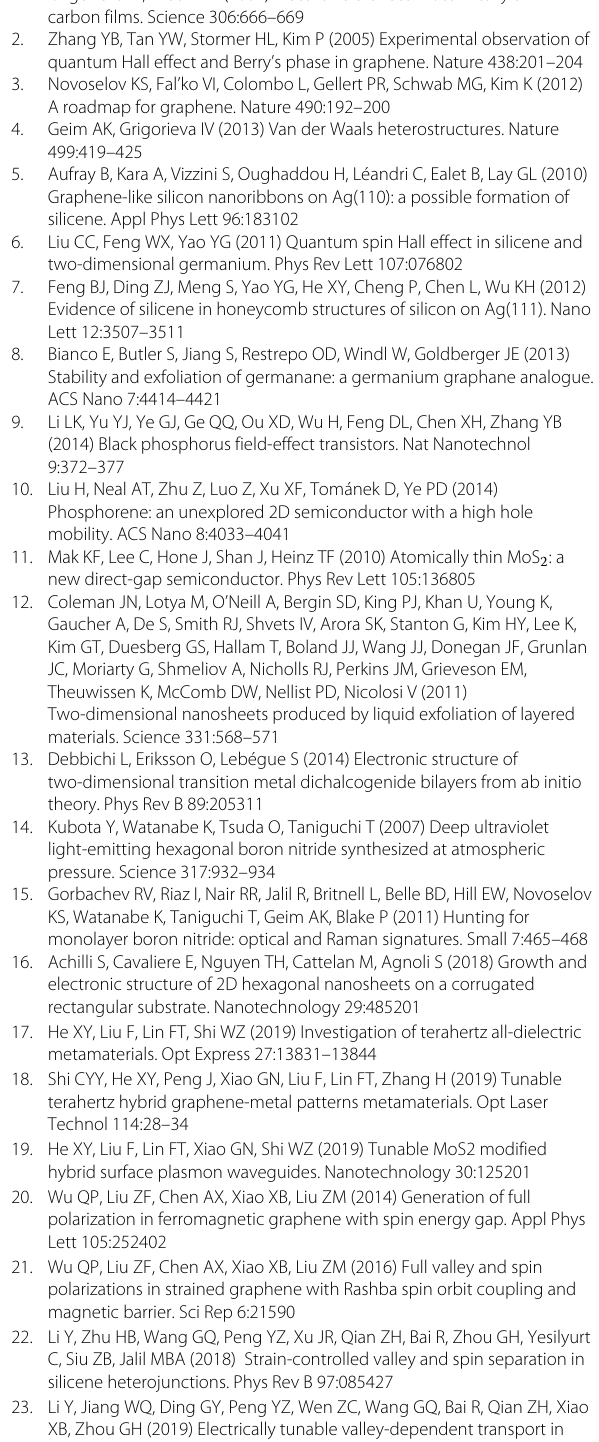
Fig. 2h, p z orbital contribution to the conduction bands is slightly changed. Therefore, the shape of these band struc- tures undergoes little affection. However, the p z orbital contribution to the valence bands is strongly modified, resulting in the change of shape of these band structures. Moreover, according to the p z orbital decomposition for the energy band of monolayer InSe with a perpendicu- lar electric field, the relative position of each conduction band keeps unchanged although gaps are opened at band crossings, as indicated by the red cycles. On the con- trary, the relative position of each valence band is changed. The energies of the lower valence bands around (cid:8) point increase and surpass those of the highest valence band finally, leading to indirect-direct band gap